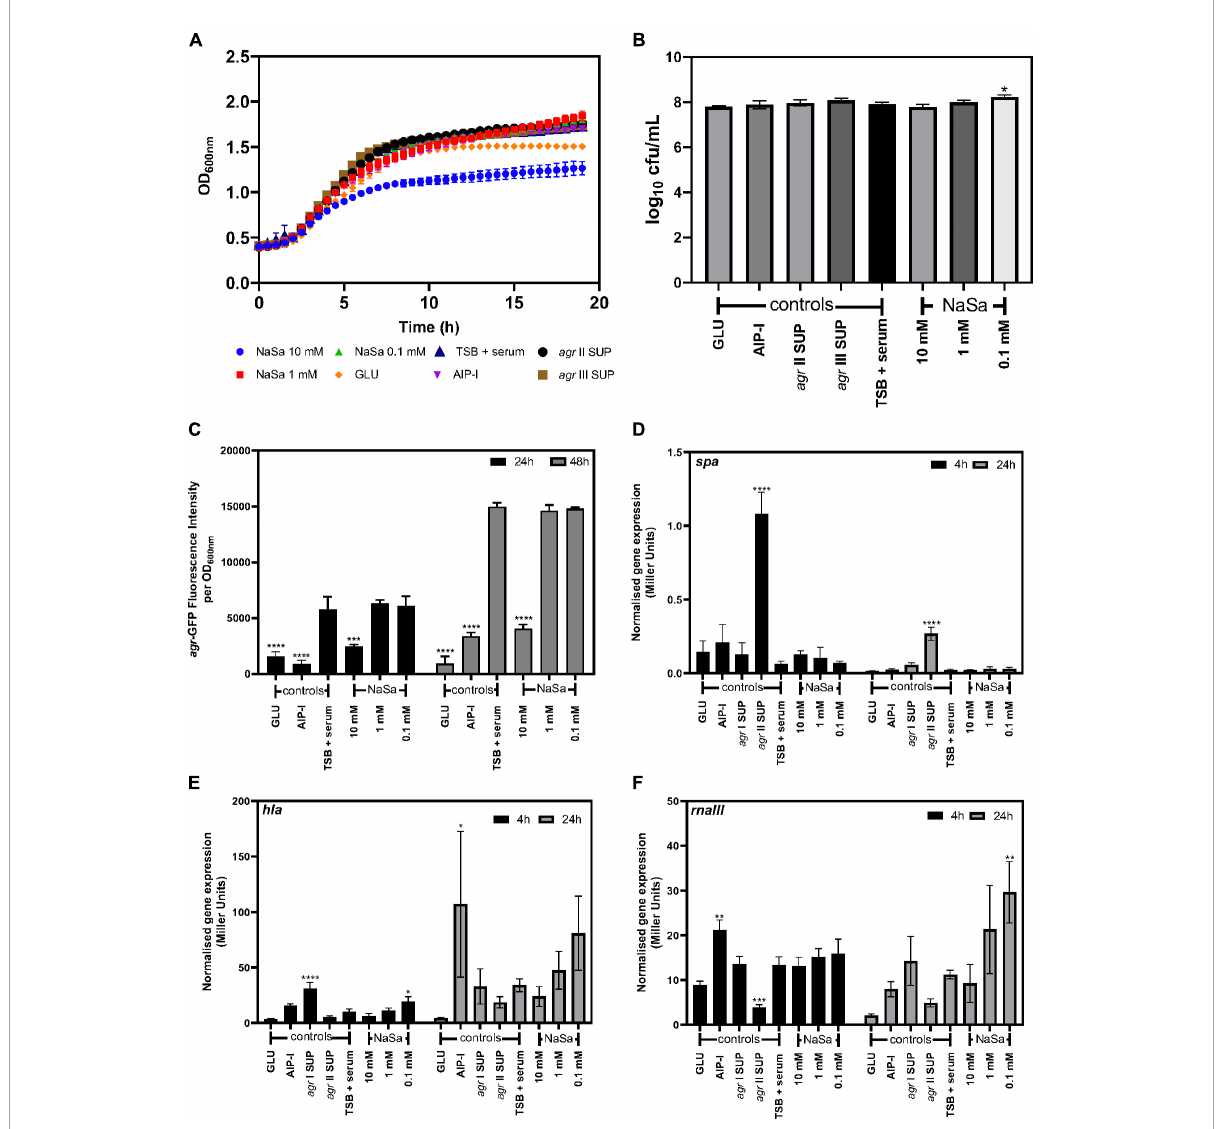
FIGURE8 Effect of NaSa on S. aureus agr expression in the presence of serum (TSB + 50% serum). Growth curves (A) and 24 h CFU counts of S. aureus ATCC 25923 (A,B) . Influence of NaSa on agr expression using the S. aureus ATCC 25923 + pCN47(TT):P2( agr )-GFP reporter strain (C) . Effect of NaSa on the expression of spa (D) , hla (E) , and rnaIII (F) in 8325-4 spa::lacZ , 8325-4 hla::lacZ , and 8325-4 rnaIII::lacZ reporter strains cultured with serum (50%) for 4 and 24 h using the liquid ONPG beta galactosidase assay. Data represent the means from three independent experiments ± SD . * P ≤ 0.05, ** P ≤ 0.01, *** P ≤ 0.001, **** P ≤ 0.0001, statistically significant to TSB (Tryptic Soy Broth) + 50% serum as media using one-way ANOVA Dunnett’s test. GLU, glucose; AIP-I, Autoinducing Peptide-I; SUP,